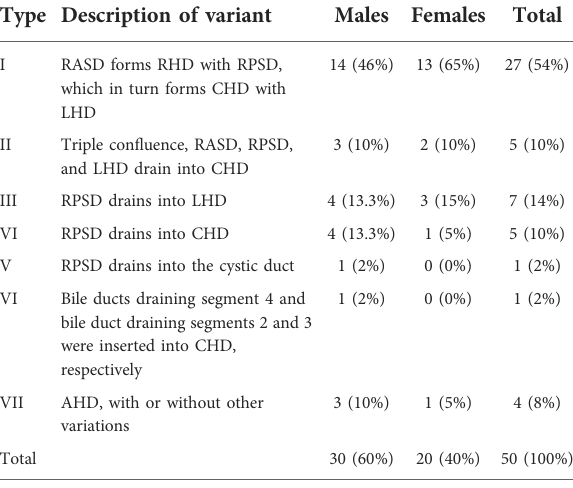
TABLE 1 Biliary tract anatomy and variation frequency based on three- dimensional visualization. Type Description of